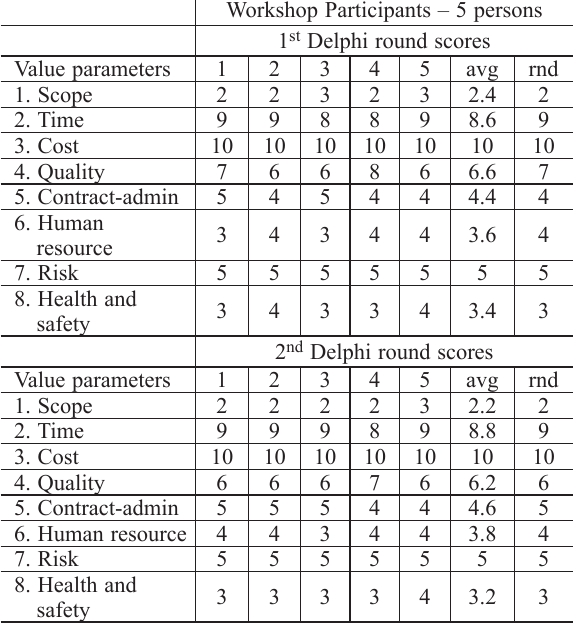
Table 3. Sample results of the EFTE exercise from one of the selected projects (5 participants)